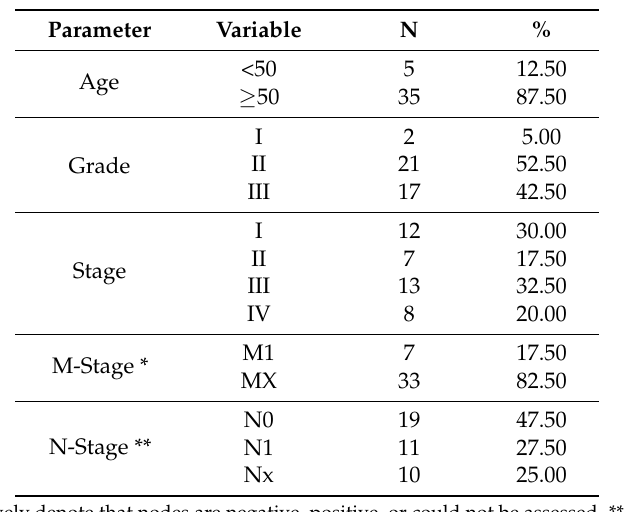
Table 2. Clinicopathological features of the 40 endometrial carcinoma cases investigated with RT-QF-PCR in the tissue cDNA